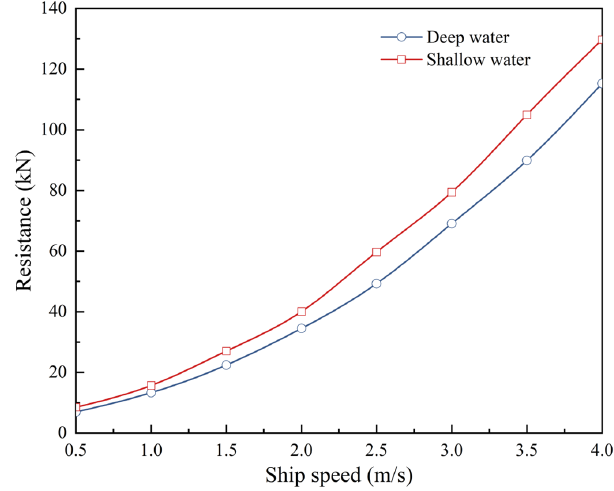
Figure 10. Comparison of ship resistance curves under deep and shallow waters.